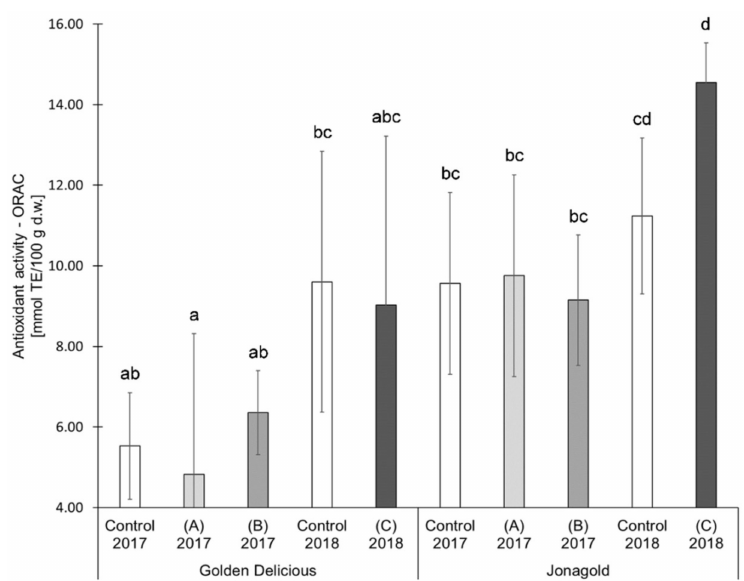
Figure 5. Results of the antioxidant activity (Oxygen Radical Absorbance Capacity Assays (ORAC) assay) in mmol TE / 100 g d.w. for the apple samples. Foliar Se application per hectare and meter canopy height: 0.15 kg as selenite (A), or selenate (B), 0.075 kg as selenate (C) ( n = 4). Di ff erent letters are significantly di ff erent (p <